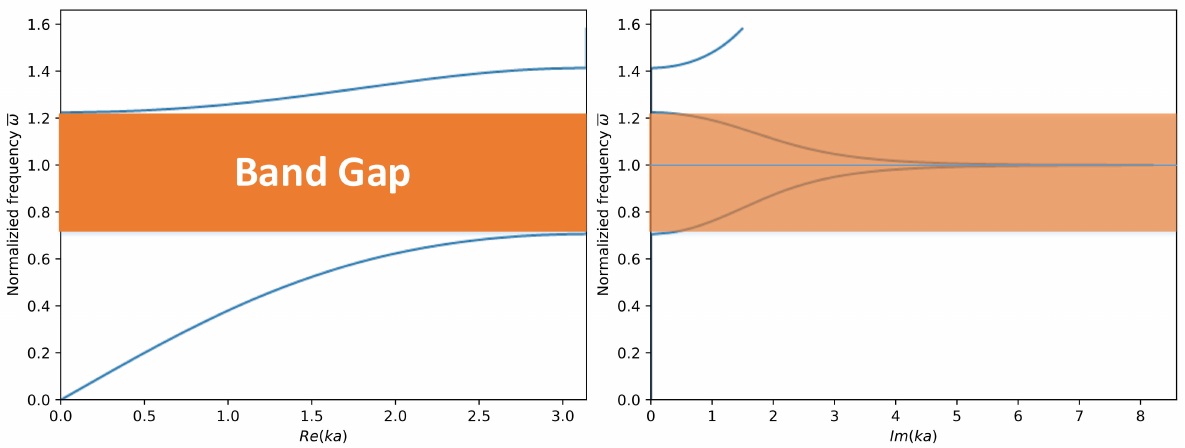
Figure 2. Dispersion curve of a one-dimensional linear elastic metamaterial with α = 0.5, β =